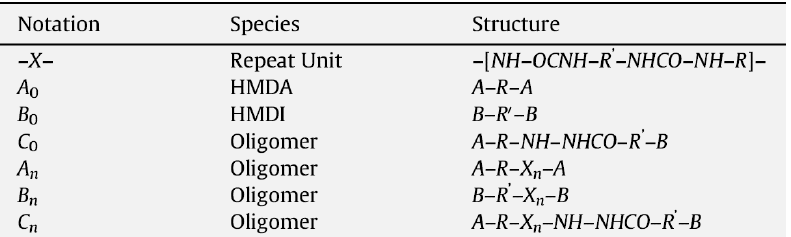
Figure 47. Table copied from reference [71]. General formulae for the different oligomeric and monomeric species that form during the reaction. The polyurea system is taken as the example here (A-: NH 2 -: B-: NCO-; R:(CH 2 ) 6 ; R’(CH 2 ) 6 ). From reference [71].